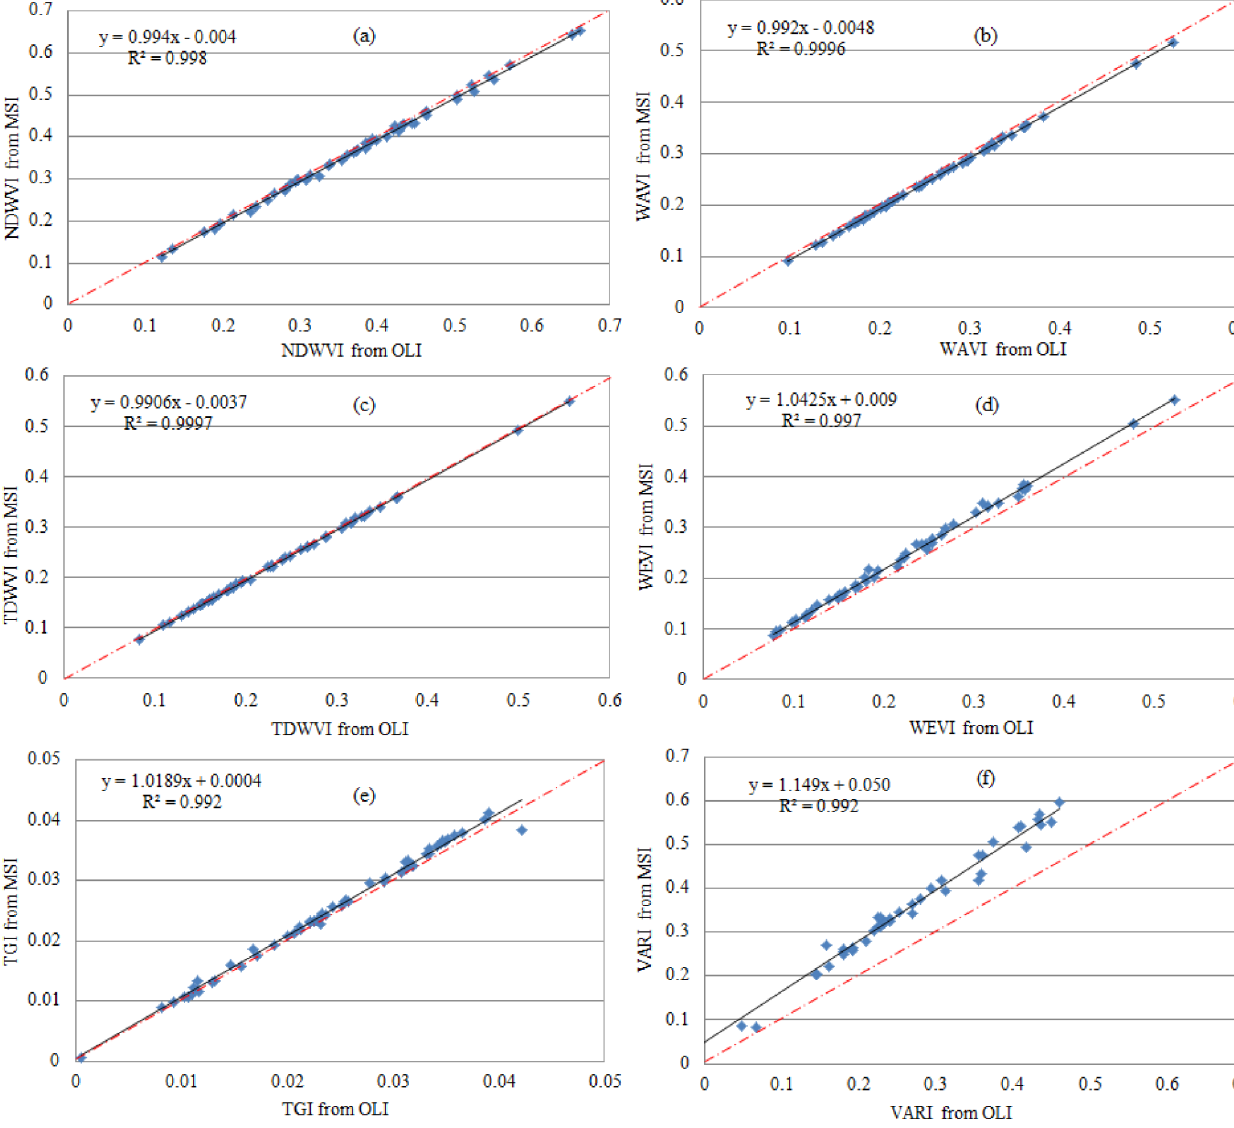
Figure 10. Scatterplots of homologous WVI derived from MSI and OLI simulated